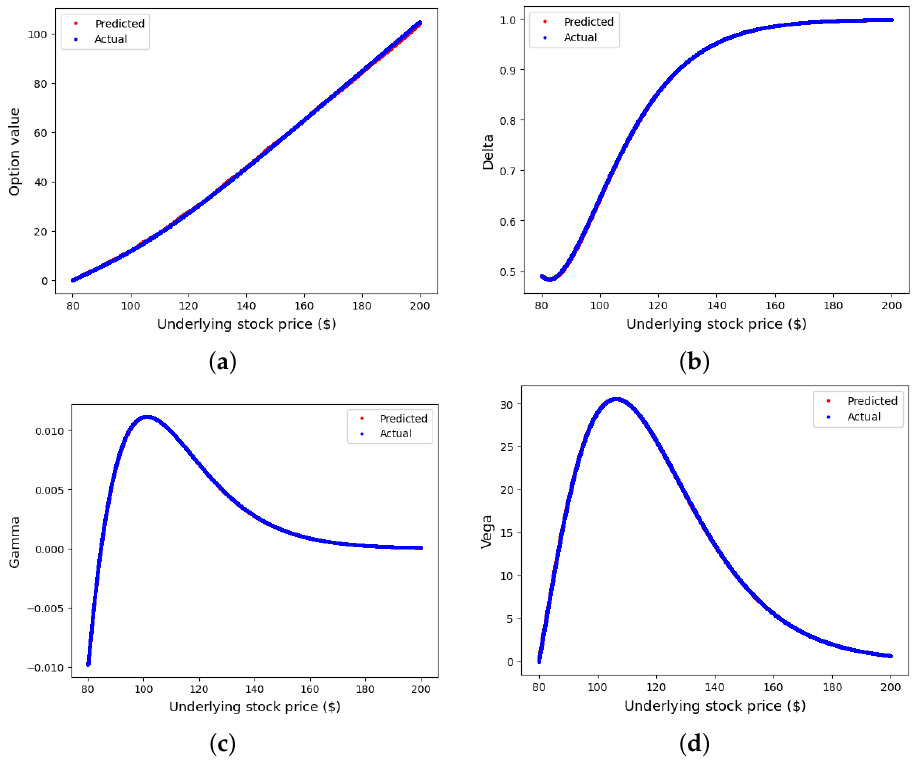
Figure 9. Option values and Greeks; ( a ) DO option value; ( b ) DO delta; ( c ) DO gamma; ( d ) DO